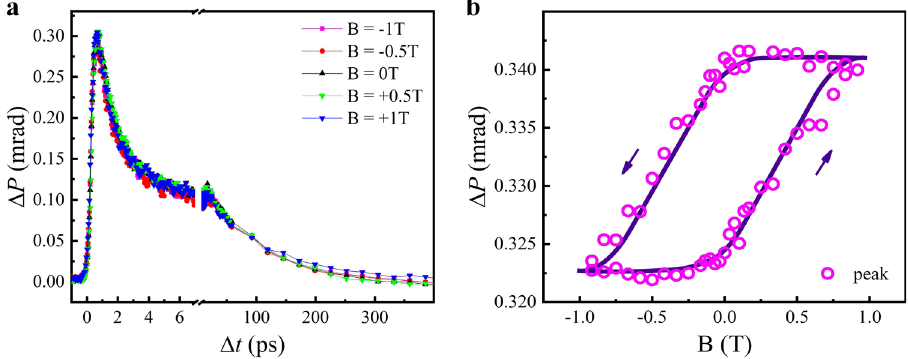
Fig. 4 Modulated MO signals of the Mn 3 Sn fi lm for different magnetic fi eld at room temperature. a Dynamic Δ P curves at various B. b Δ P loop by sweeping B and fi xing the time delay Δ t at the peak position of the dynamic Δ P curves. The solid line is a guide to eye. NATURE COMMUNICATIONS| (2021) 12:5266